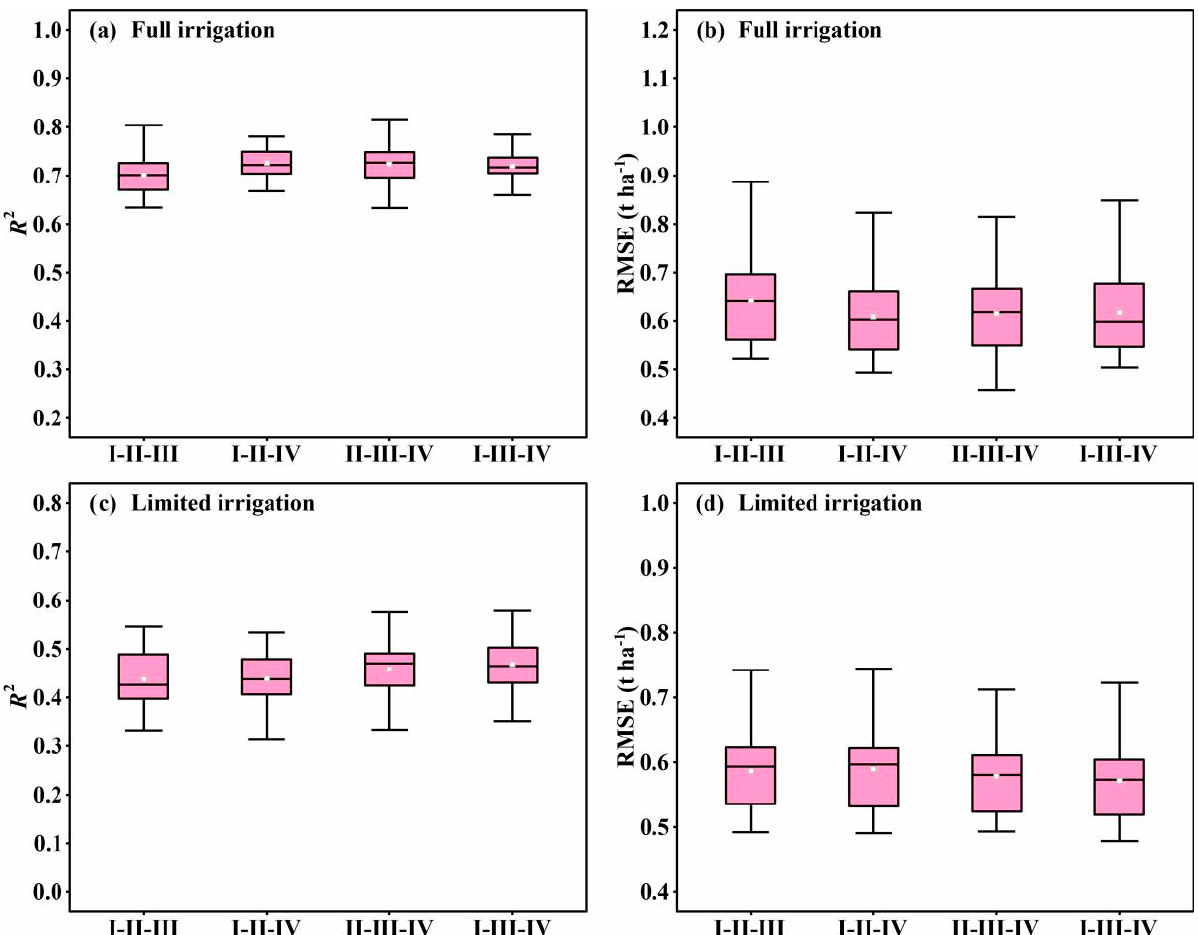
Figure 6. ( a – d ) The statistical distributions of model performance for predicting grain yield that stack three growth stages under full and limited irrigation treatments. Abbreviations: I-II-III, stacking traits from flowering, early and mid grain fill; I-II-IV, stacking traits from flowering, early and late grain fill; II-III-IV, stacking traits from early, mid and late grain fill; I-III-IV, stacking traits from flowering, mid and late grain fill.